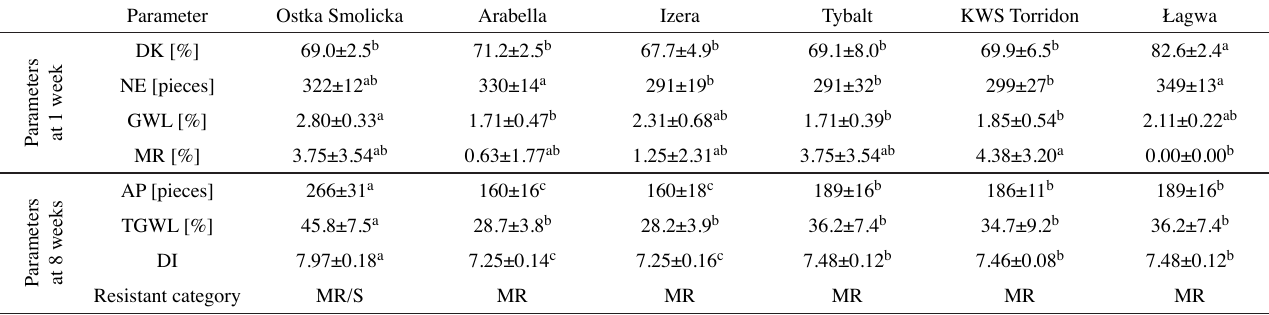
Tab. 1: Parameters of development of S. granarius on grain of the studied spring wheat cultivars after 1 week and 8 weeks of